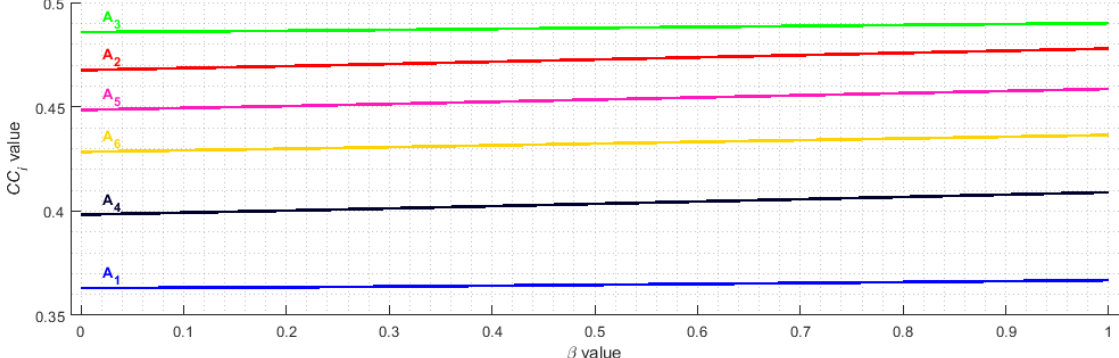
Figure 5. Closeness coefficient values depending on the 𝛽 coefficient.